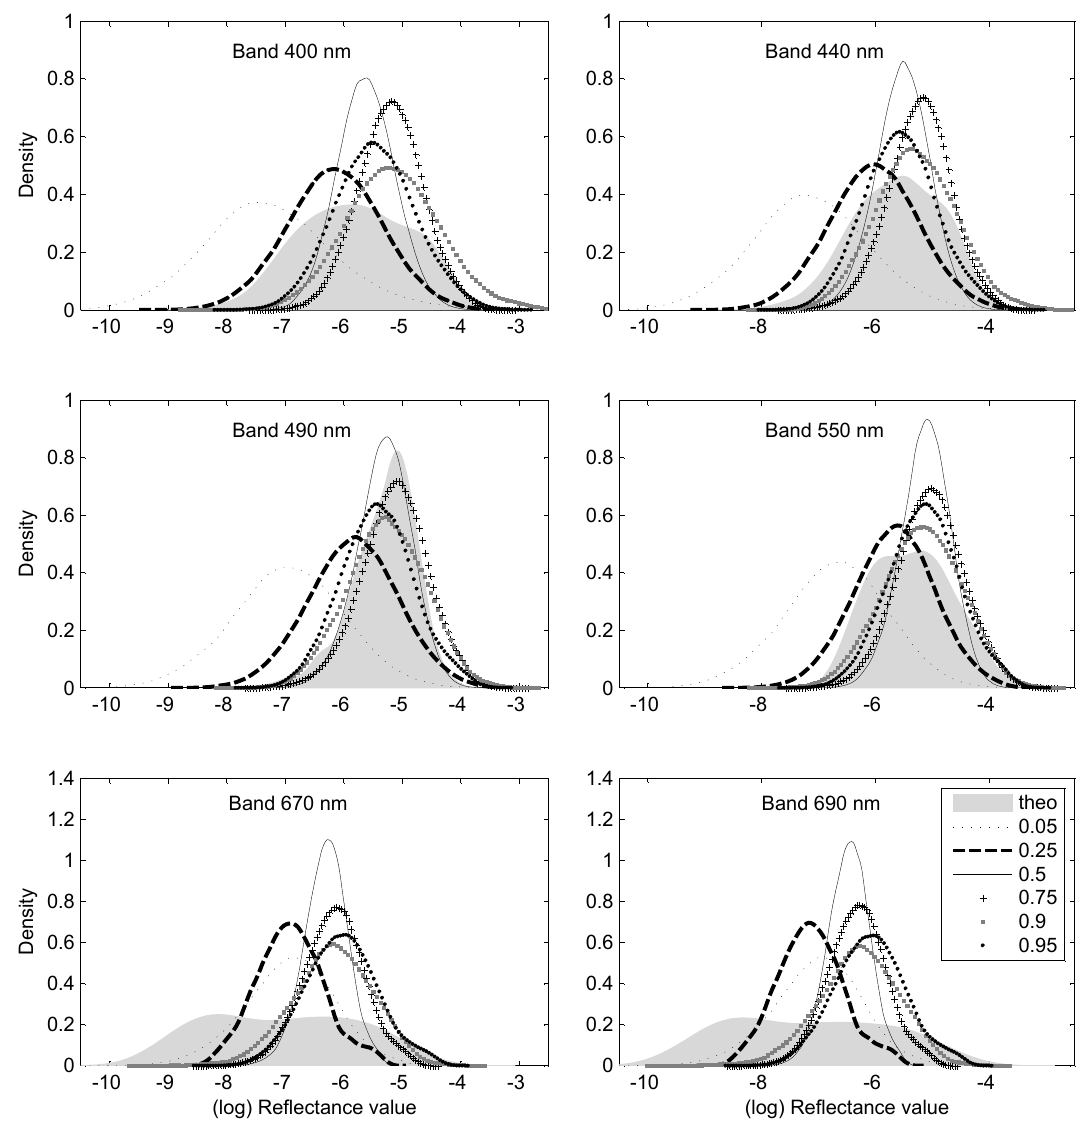
Empirical PDFs generated from field spectra corresponding to predefined quantiles: 0.05 “doted line”, 0.25 “dashed line”, 0.5 “full line”, 0.75 “plus”, 0.9 “square”, 0.95 “circles” for six wavelengths. The theoretical PDF is illustrate as gray